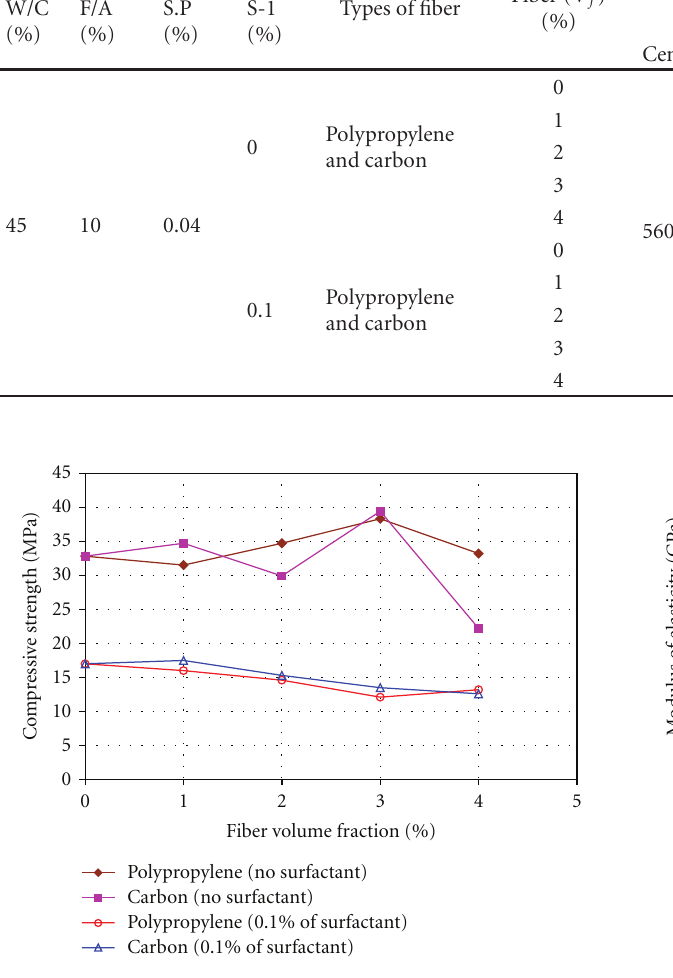
Figure 2: Fiber volume fraction versus modulus of